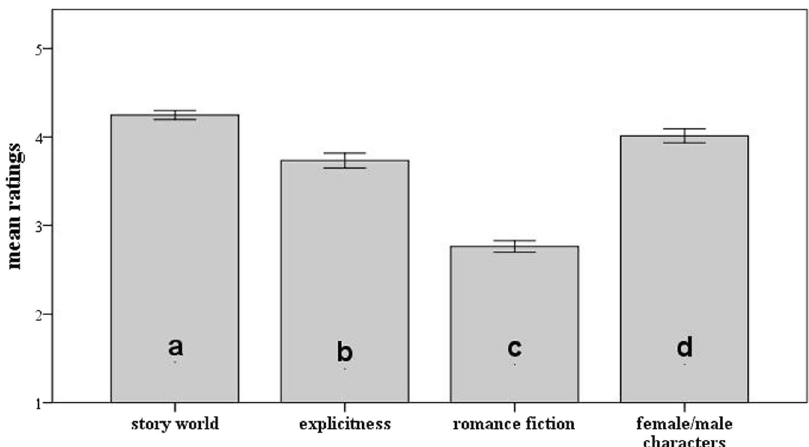
Fig. 1 Mean ratings for each of the four components re fl ecting important features of erotic novels. Error bars indicate the standard error of the mean. Means with different letters are signi fi Table 2 Component loadings for a principle components analysis (PCA) with oblimin rotation of the items describing participants ’ predominant opinion on erotic novels ( N = 427).